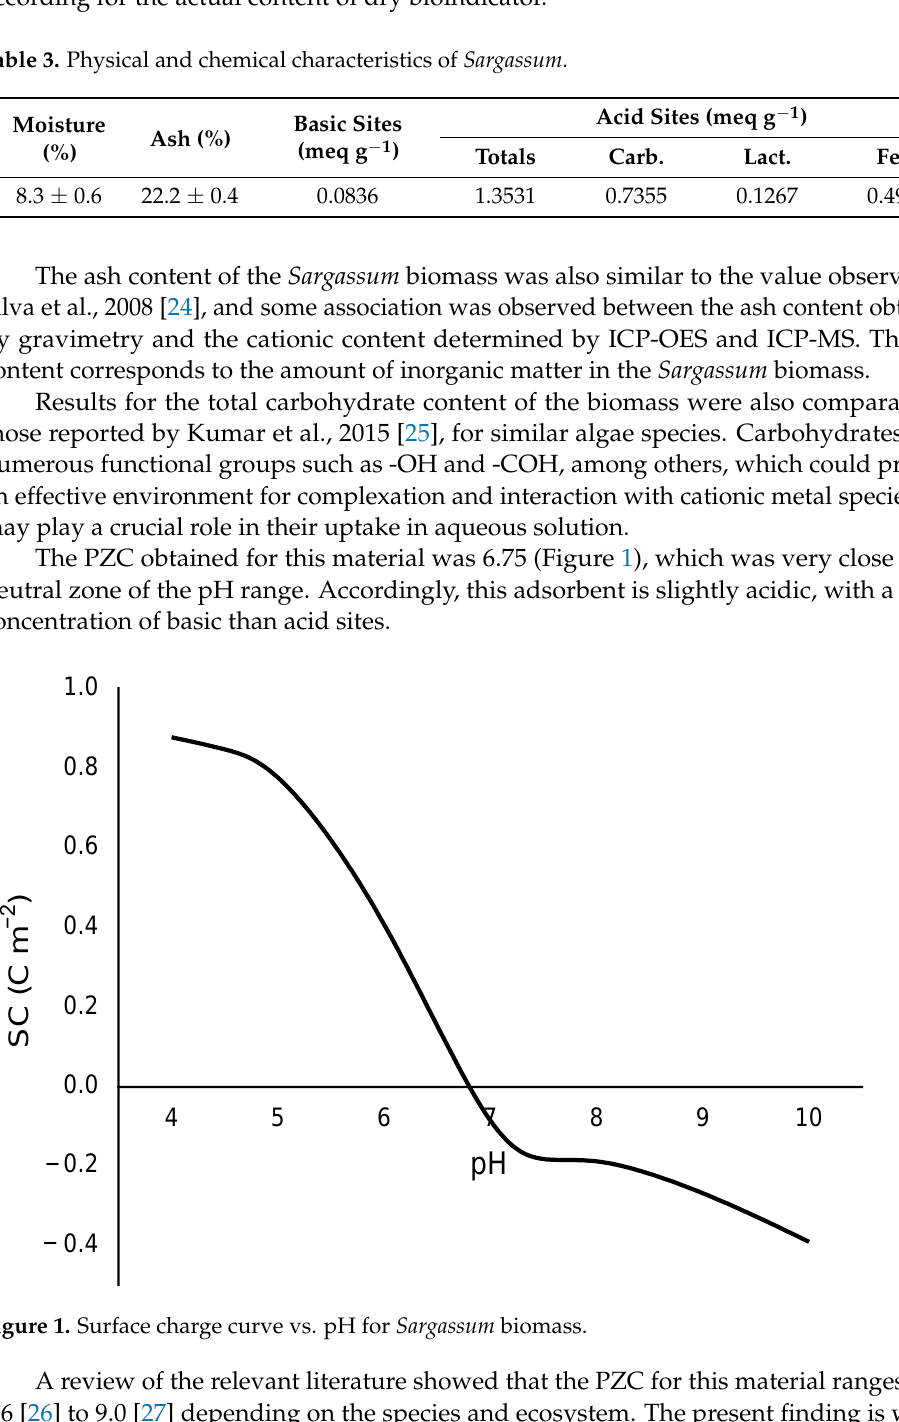
Table 3. Physical and chemical characteristics of Sargassum .